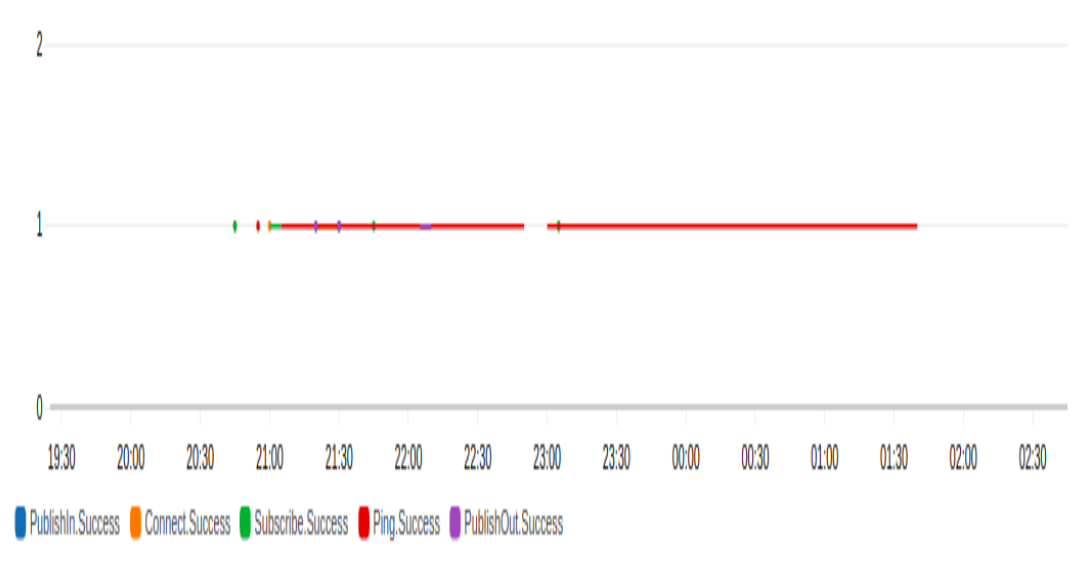
Figure 10. Running Greengrass successfully on the Raspberry Pi 4 kit.